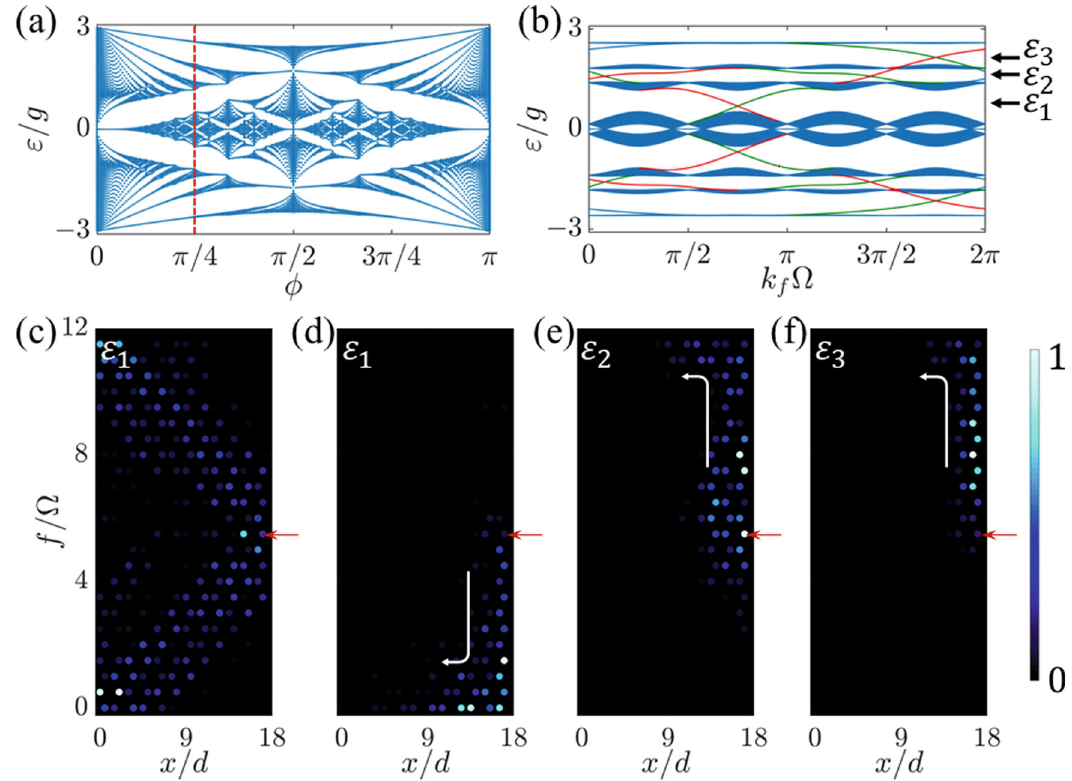
Fig. 4 Topological edge states with an effective magnetic fi eld. a The projected band structure of the honeycomb lattice in Fig. 1c along modulation phase ϕ . The red dashed line refers to ϕ = π /4. ε is the frequency shift of the fi eld, and g is the effective hopping amplitude. b The projected band structure in fi nite rings with ϕ = π /4, where k Ω is the free spectral range. Bands labeled in red (green) f is the wave vector reciprocal to the frequency axis, and represents edge states on the right (left) boundary of the synthetic lattice. ε 1 , ε 2 , and ε 3 label three different frequencies in the band structure. c The simulated intensity distribution as a function of spatial dimension ( x ) and frequency dimension ( f ) at propagation time t = 20 g − 1 with the input fi eld having frequency shift ω s = ε 1 for the case ϕ = 0. Simulated intensity distributions at t = 20 g − 1 for the case ϕ = π /4 with the input fi eld having frequency shift ω s being d ε 1 , e ε 2 , and f ε 3 , respectively. d is the horizontal distance between two sites with the same types in the synthetic lattice. The red arrow indicates the m = 5th resonant frequency mode in the rightmost ring is excited. White arrows denote the unidirectional